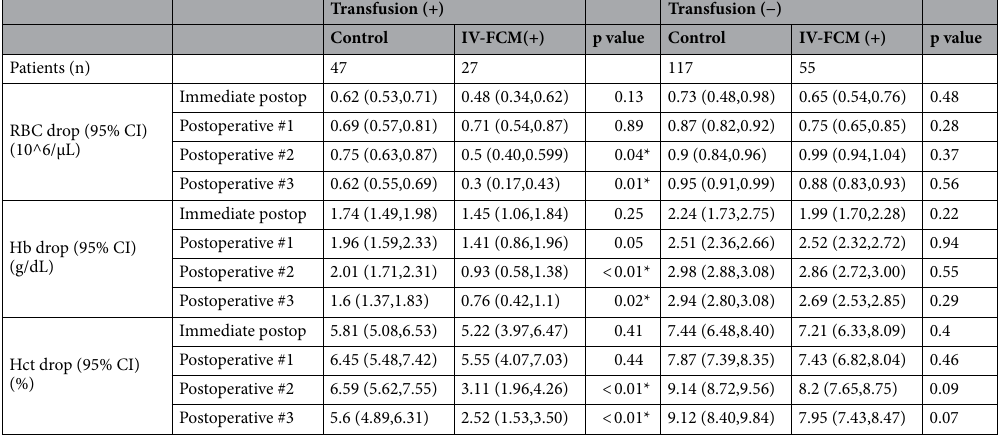
Table 2. Comparison of hemodynamic changes between the transfusion group and non-transfusion group from postoperatively. Abbreviations : IV-FCM : Intravenous ferric carboxymaltose , RBC : Red blood cell count, Hb : Hemoglobin, Hct : Hematocrit.